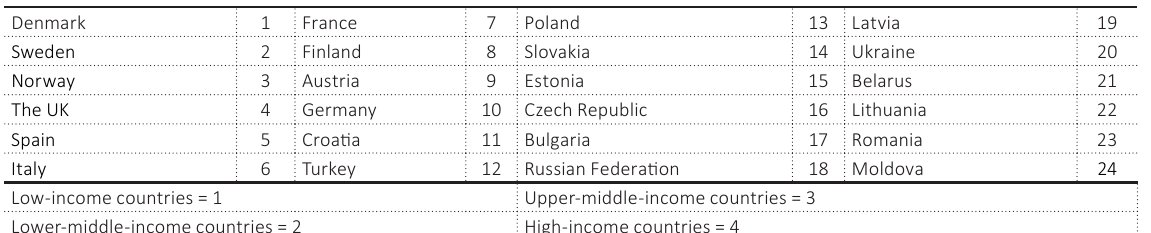
Figure 2. The relationship between the income level in the country and the share of bank assets in